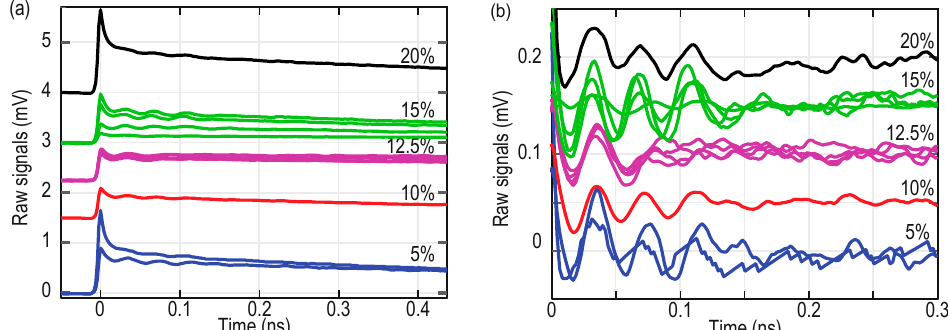
Figure 7. ( a ) Raw measurements of the transient probe reflectivity in the (Bi 1 − x Pr x )(Fe 0.95 Mn 0.05 )O 3 films deposited on LaAlO 3 (LAO) for probe incidence at ψ = 0 ◦ . ( b ) The acoustic part of the signals obtained in the (Bi 1 − x Pr x )(Fe 0.95 Mn 0.05 )O 3 films deposited on LAO after the subtraction of the low-frequency contribution of non-acoustic origins to reflectivity. Each percentage denotes the Pr substitution concentration associated with the curves just below it, and each curve at a given substitution concentration corresponds to a different probed location on the sample.